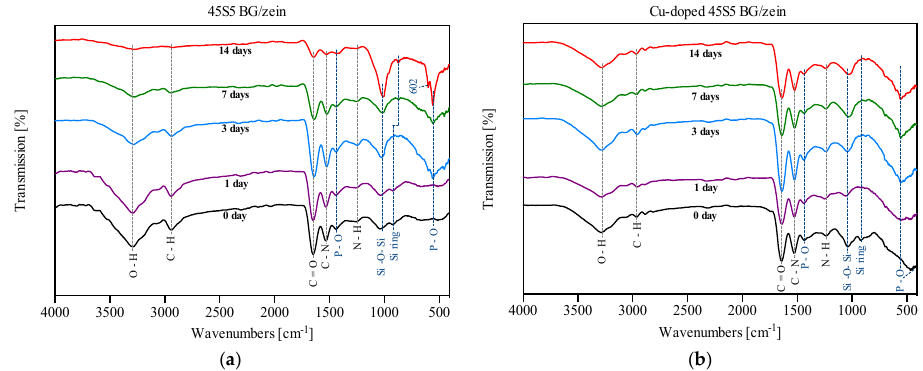
Figure 3. FTIR results on coatings before and after immersion in SBF for up to 14 days: ( a ) 45S5 BG/zein coatings; ( b ) copper-doped 45S5 BG/zein coatings. The main vibration bands of zein (blue dashed line) and BG (black dashed line) are depicted.